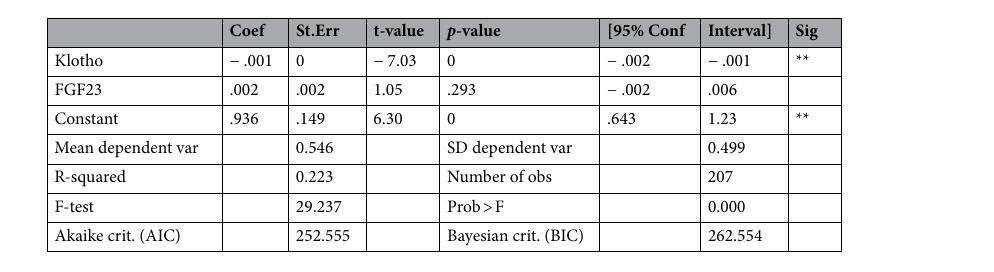
Table 4. Multivariable logistic regression for MALE. ** p < .01.